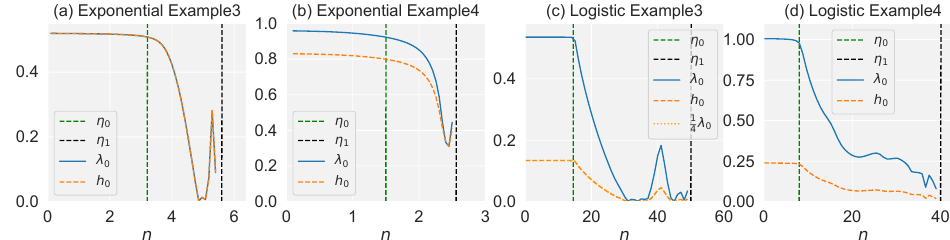
Figure 3. Top eigenvalue of the NTK ( λ 0 ) and Hessian ( h 0 ) measured at t = 100 as a function of the learning rate, with ( a , b ) exponential loss and ( c , d ) logistic loss in Examples 3 and 4. The green dashed line η = η 0 represents the boundary between the lazy and catapult phases, while the black dashed line η = η 1 separates the catapult and divergent phases. We adopt the settings of σ 2 w = 0.5 and m = 100 for exponential loss, and the settings for logistic loss are σ 2 w = 0.5 and m = 200. ( a , c ) The curves of the maximum eigenvalue of the NTK and Hessian coincide as predicted by the Corollary A1. ( b , d ) For non-separable data, the trend of the two eigenvalue curves is consistent with the change in the learning rate.